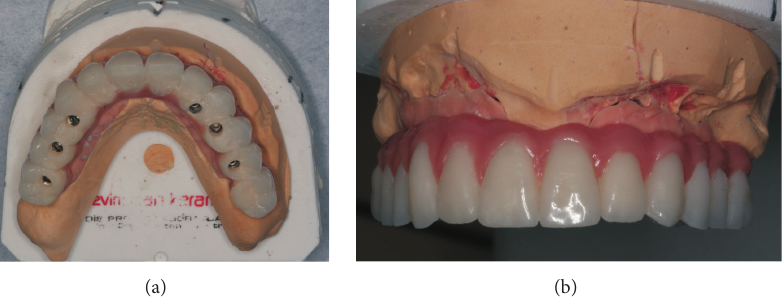
Figure 11: (a) Frontal and (b) occlusal view for hybrid prosthesis.